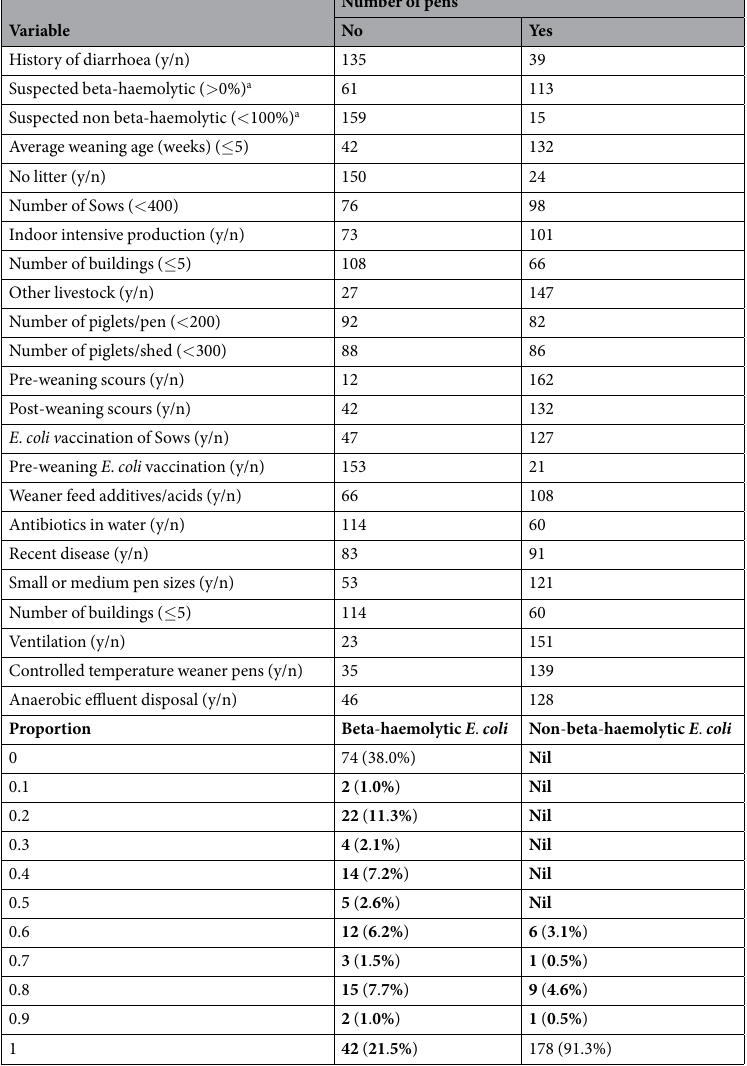
proximity measure (whereas we asked specifically “Do you run other livestock on the same property?”), this suggests that by minimising such risk factors associated with E . coli scours producers could also minimise other diseases known to have dramatic impacts on pig production. We found that only one farm had neither ownership of other livestock nor pre-weaning scours, making it difficult to draw robust conclusions. However, ownership of other livestock could be an indicator of inadequate biosecurity, or might increase the risk of pathogenic strains of E . coli being introduced to a pig herd. This risk factor is worthy of further investigation. It is a common practice for Australian pig producers to raise other livestock on their farm (van Breda et al . 14 ). Though statistically biased (due to separation in the data), the majority of farms analysed had both other livestock on the same farm and pre-weaning scours. This is suggestive of transmission between animals 18 . Once within a pen, smaller management units tend to be less prone to post-weaning scours, however this depends on the management context of a production system 19 . It would be useful to examine alternative causes of scours